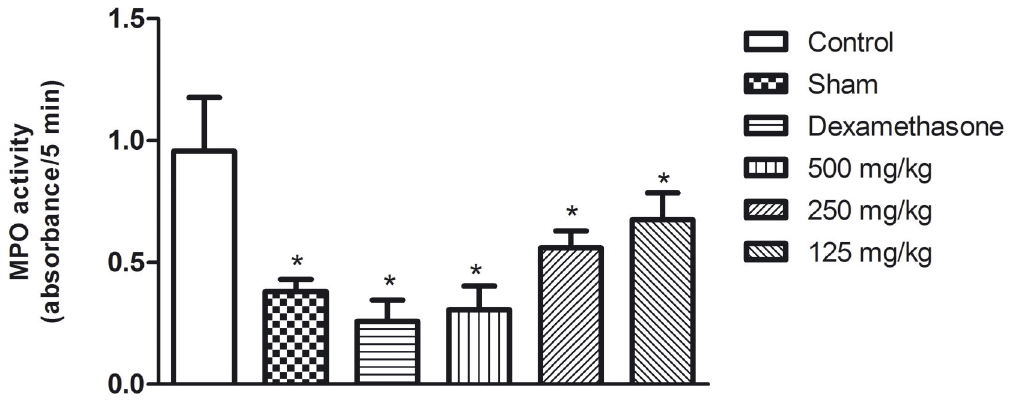
Figure 7. The effect of the aqueous seed extract on myeloperoxidase activity in the lungs of mice with carrageenan- induced pleurisy. The data are presented as the means ± standard deviation; n = 6 animals/group. *p<0.05 in comparison with the controls by ANOVA followed by Newman-Keuls